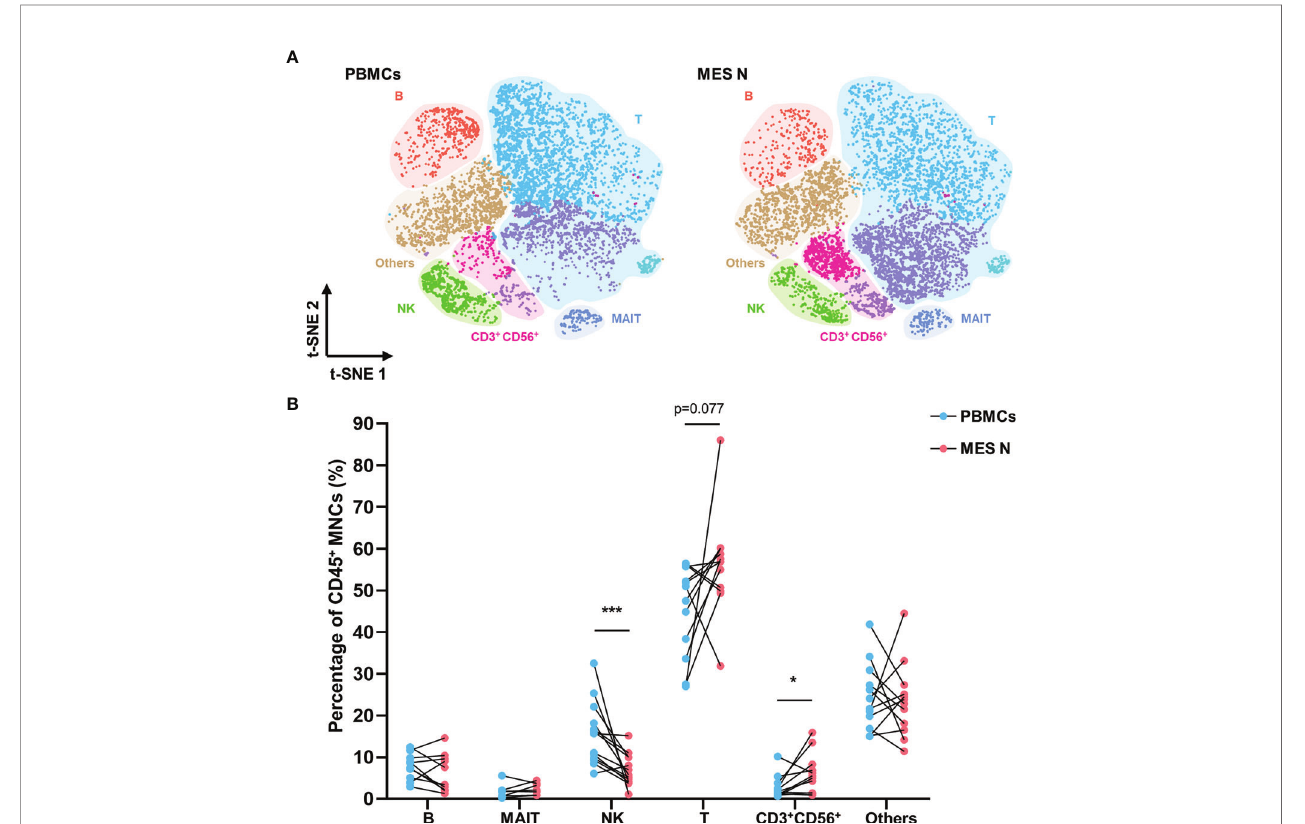
FIGURE 1 | T-SNE plot and percentages of CD45 + MNCs in the PBMCs and MES N. (A) T-SNE plot of CD45 + MNCs in the PBMCs and MES N with main subclusters indicated. (B) Percentages of B cells, MAIT cells, NK cells, T cells, CD3 + CD56 + cells, and other cells (monocytes/macrophages and dendritic cells) in the PBMCs and MES N. (*p < 0.05; ***p <